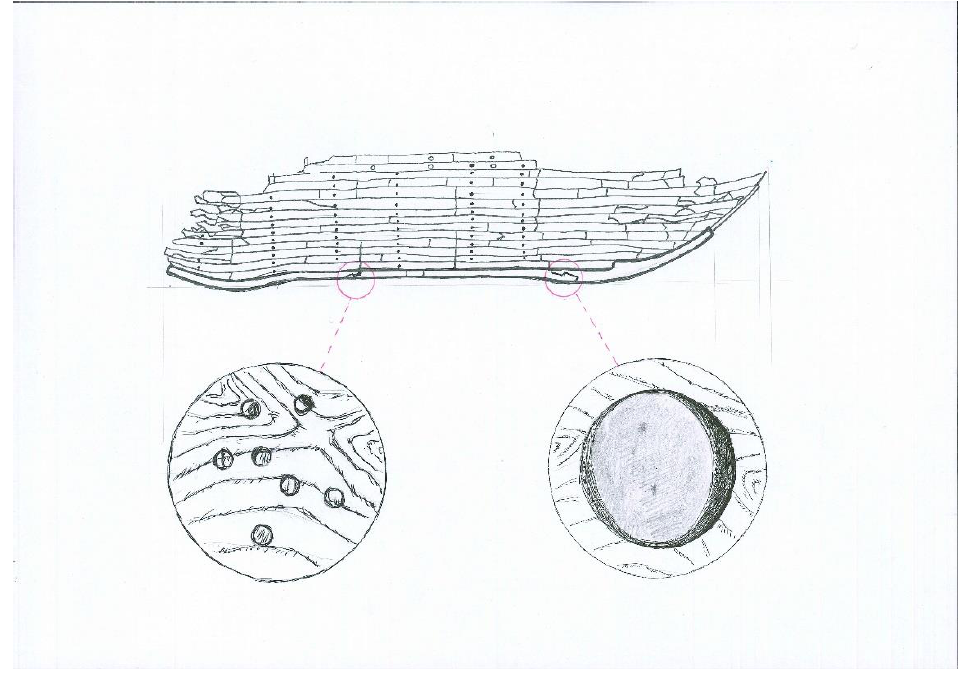
Figure 3. Line drawing of the carved seven-dots image in the Sinan shipwreck. Line drawing based on (National Research Institute of Maritime Cultural Heritage 2016, p. 64). Courtesy of Mr. Eason Y. Wang.